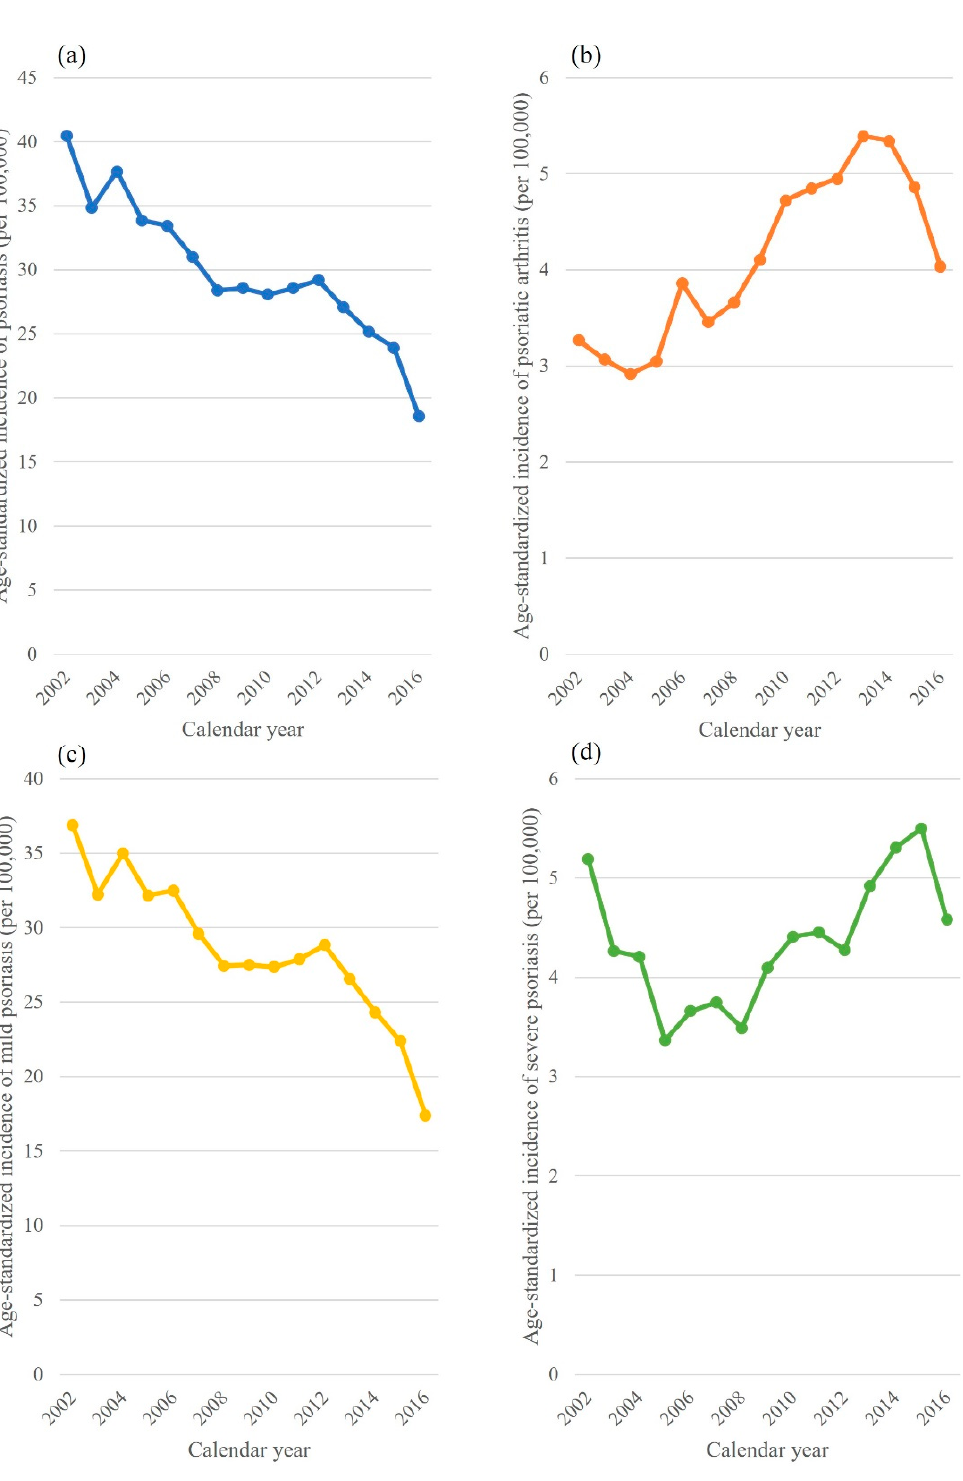
Figure 1. Age-standardized incidence rate of ( a ) psoriasis, ( b ) psoriatic arthritis, ( c ) mild psoriasis, and ( d ) severe psoriasis.